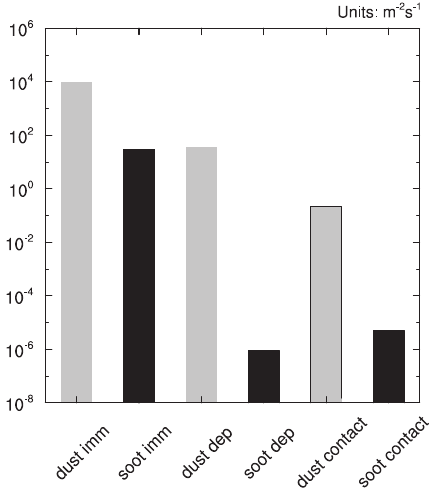
Figure 6. Global and annual mean vertically integrated nucleation rates in the PDF